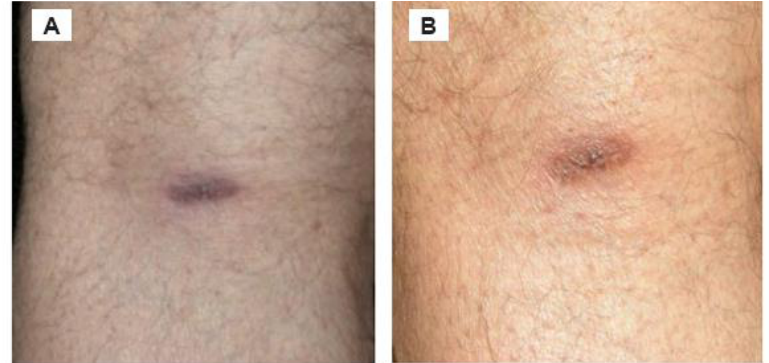
Figure 2. ACA located on the posterior side of left knee, and there was no recent involvement of a tick bite. ( A ) Rash when noticed. ( B ) Rash 4 months later. Of note, the synovial membrane and synovial fluid of the knee are prime foci for sequestration of Lyme disease spirochetes.